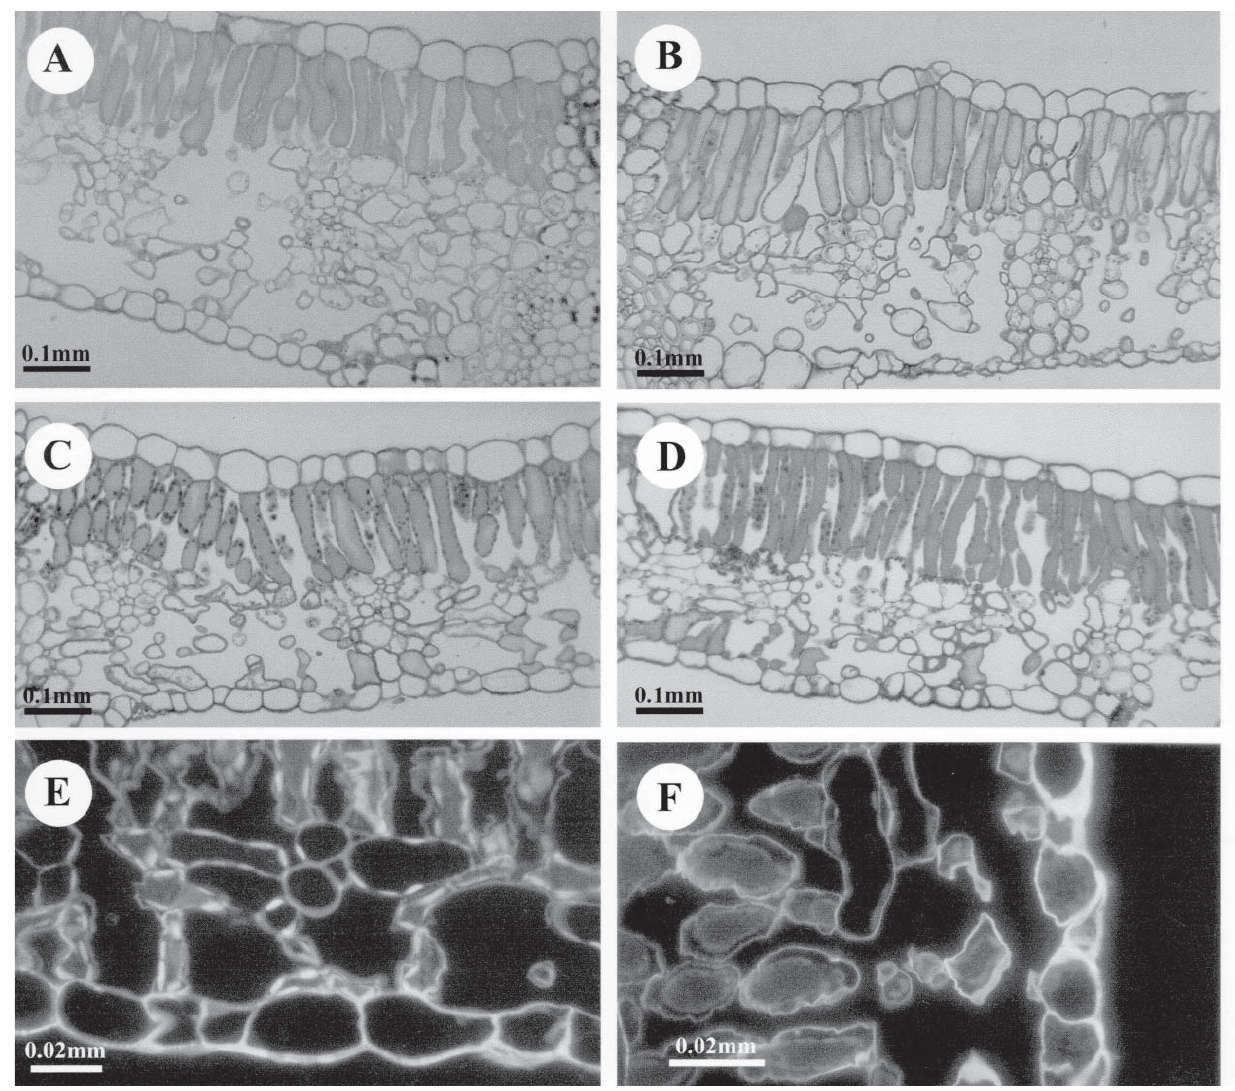
Fig. 1. Light microscopy sections of Platanus acerifolia leaves after the first experiment. (A, B) Half leaves treated with distilled water droplets after 24 and 48 h: the leaf anatomy is completely normal; note the absence of starch grains in all cells. Bar=0.1 mm. (C, D) The same half-leaves treated with pure cerato-platanin (CP) after 24 and 48 h: the palisade and spongy cells. The latter, especially after 48 h, show numerous starch grains in the cytoplasm. Moreover, the palisade cell cytoplasm has a brighter colour than the control(s) due to higher levels of phenols. Bar=0.1 mm. (E, F) Intercellular and intracellular disorganization in spongy leaf tissue caused by treatment with Ceratocystis fimbriata f. sp . platani and CP respectively. Cell plasmolysis processes are particularly evident in the CP-treated leaf. Bar=0.02